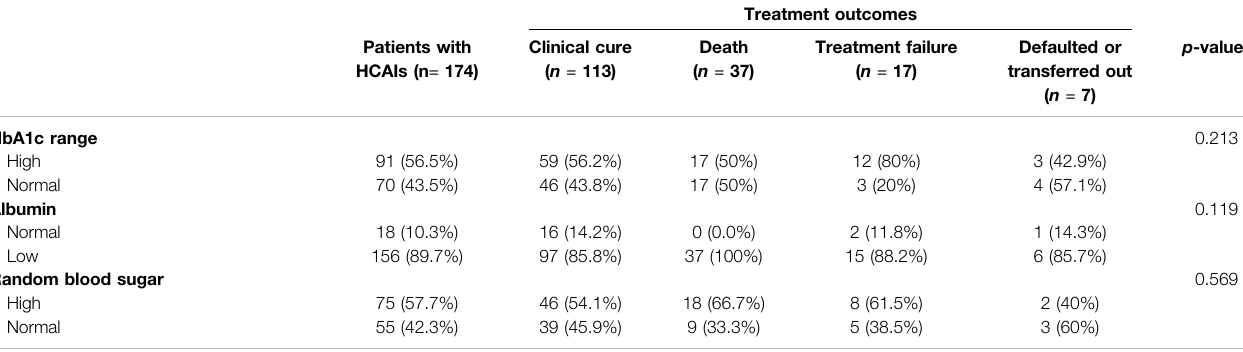
Univariate multinomial logistic regression Odds ratio [95% CI (signi fi cance; p